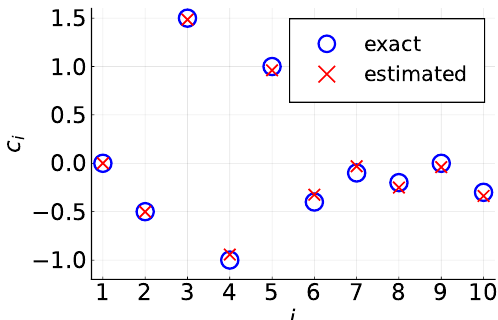
Figure 3. The lifting identification method is used to recover the dynamics (19) on a graphon. The coefficients c i (blue circles) are correctly estimated (red